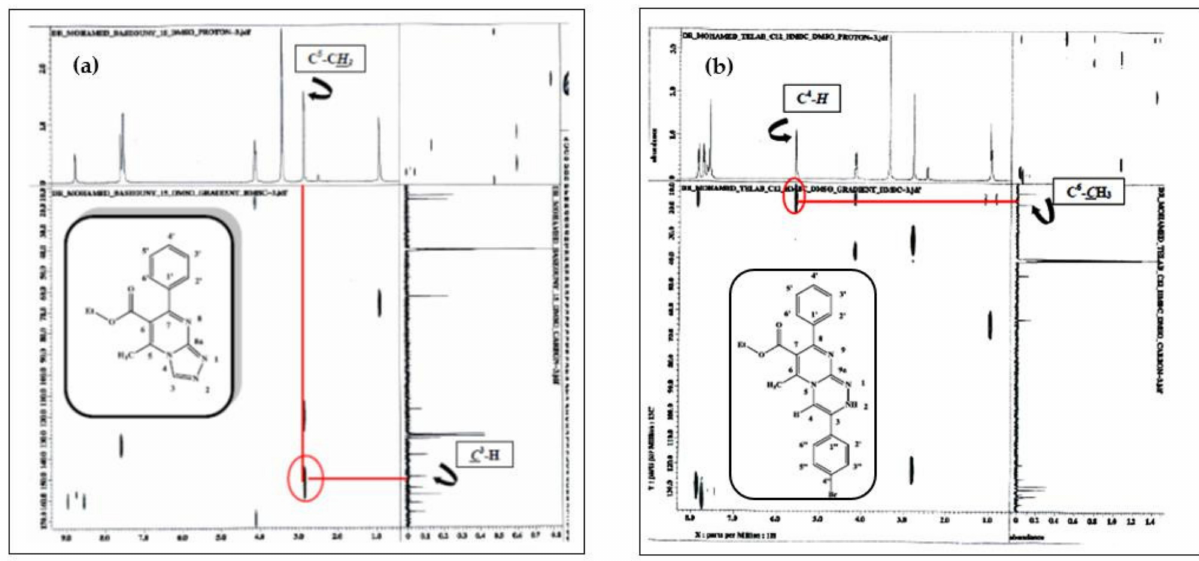
Figure 3. ( a ) HMBC spectrum of compound 13 ; ( b ) HMBC spectrum of compound 14b